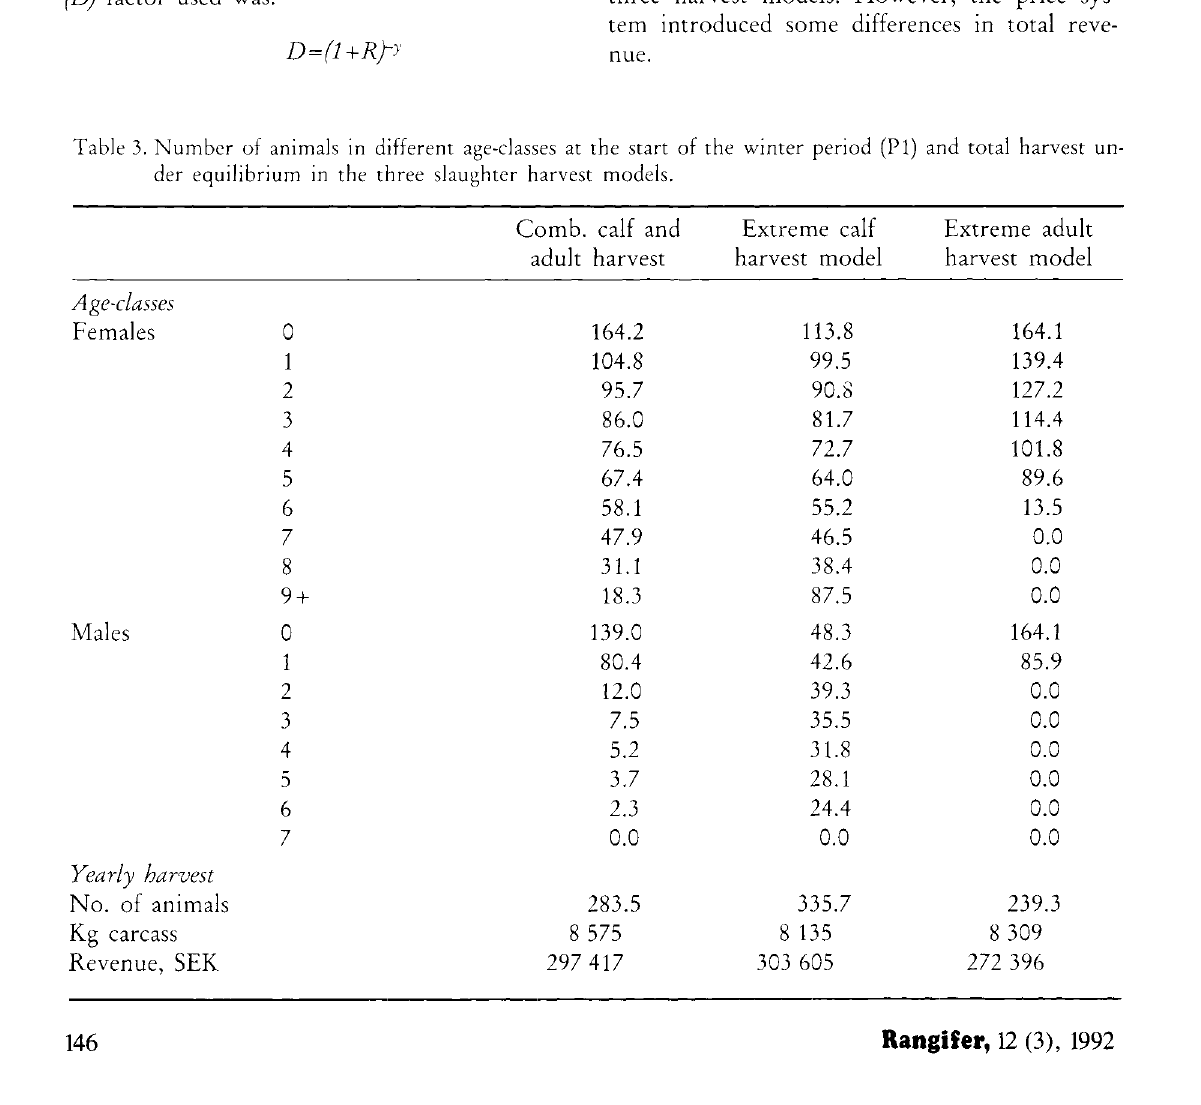
Table 3. Number of animals in different age-classes at the start of the winter period (Pi) and total harvest un der equilibrium in the three slaughter harvest